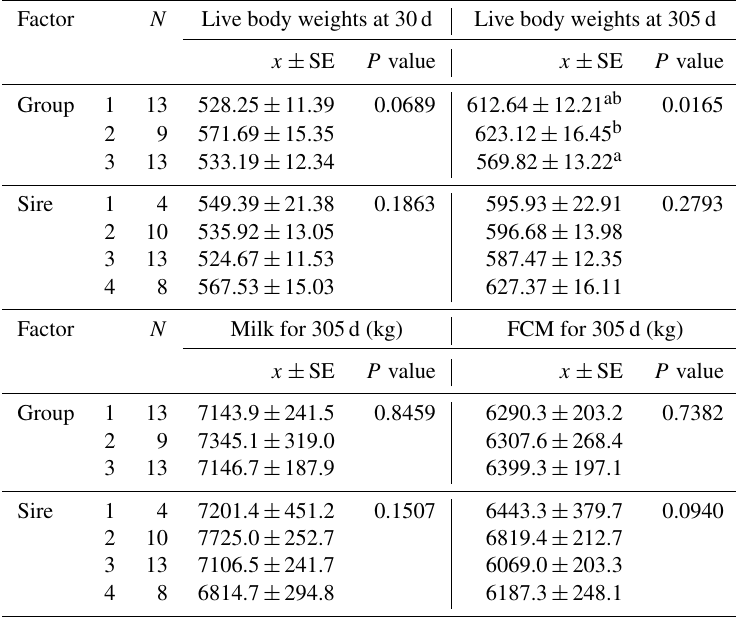
Table 1. Growth and milk performance in the first lactation.